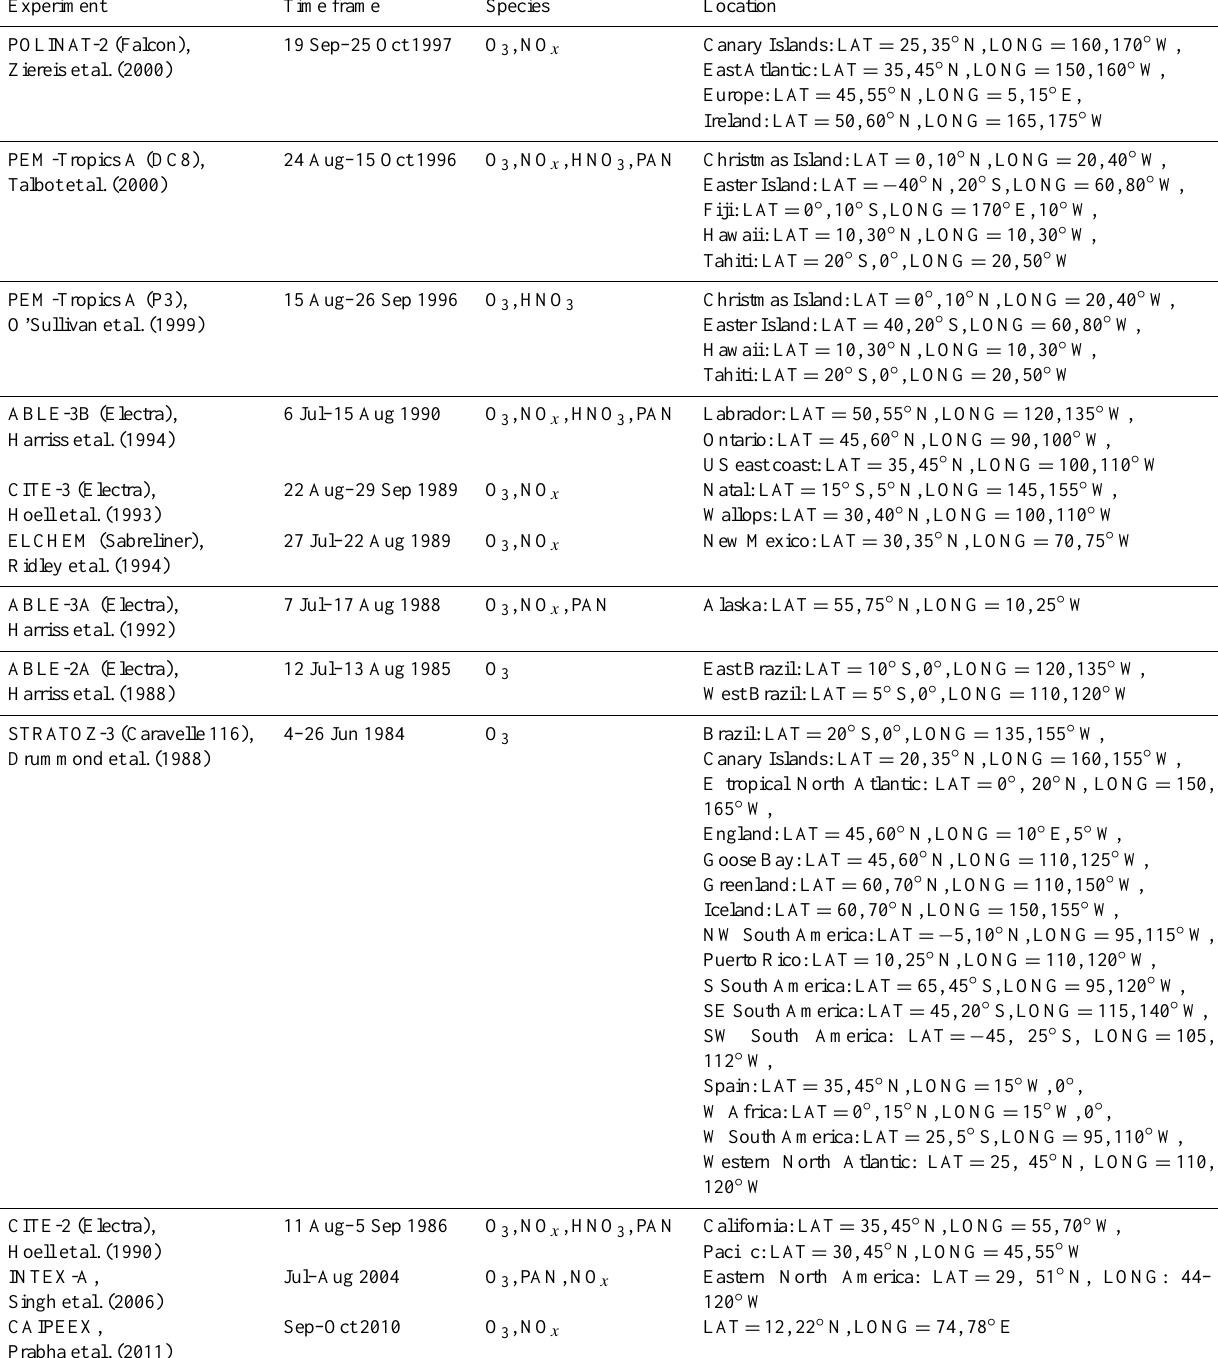
Table 1. Global aircraft measurements used for model evaluation. Experiment Time frame Species